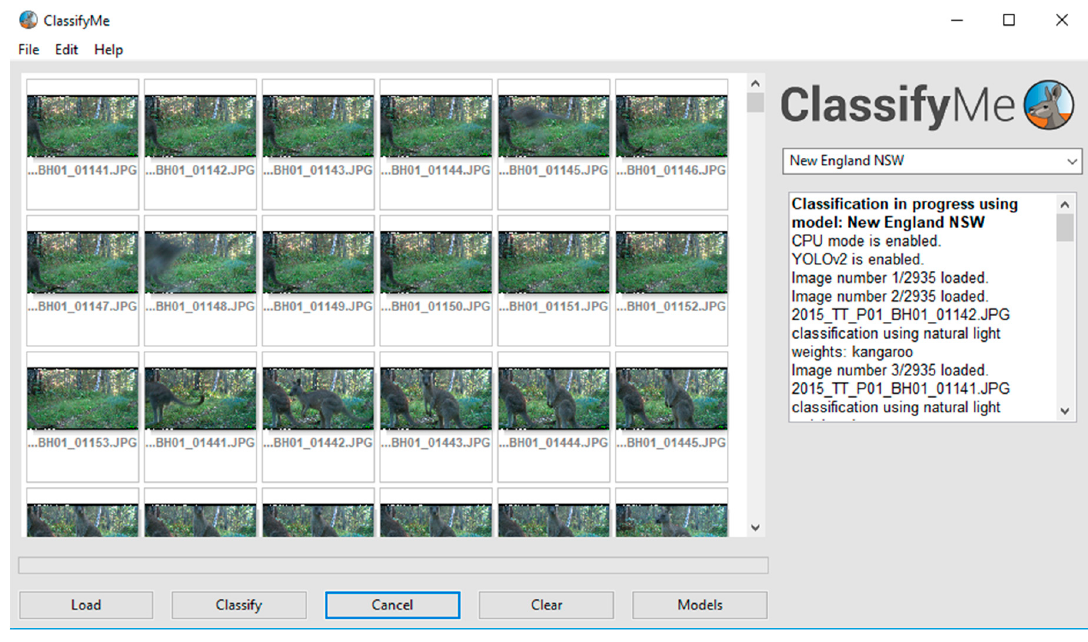
Figure 2. The ClassifyMe main user interface.